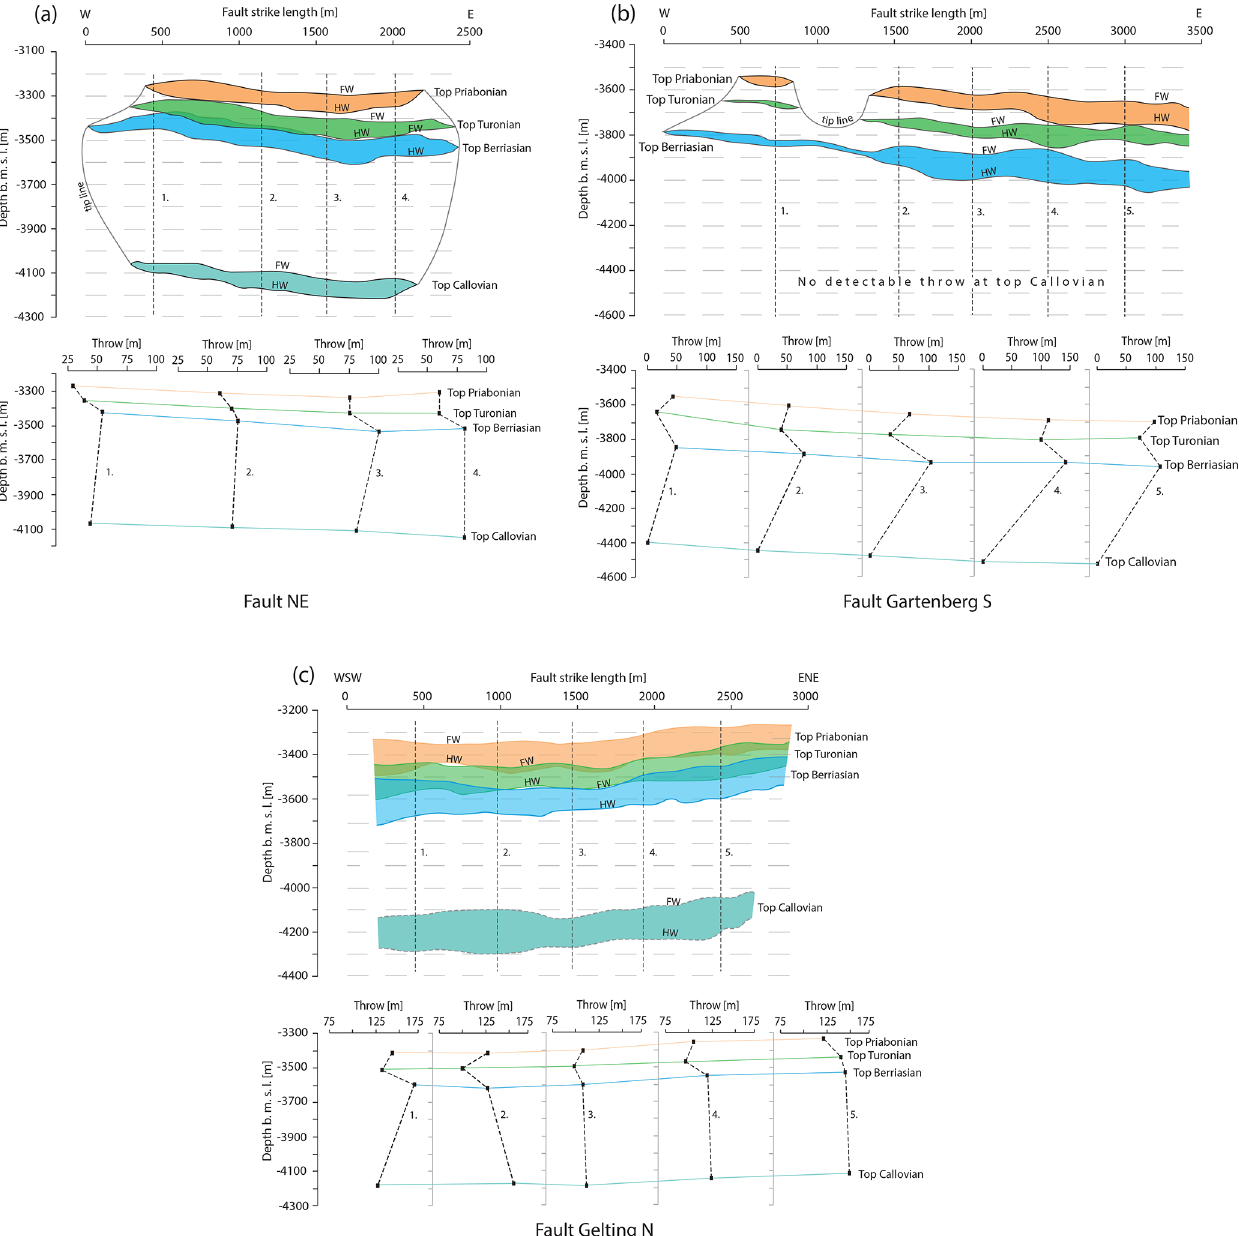
Figure 8. Allan maps and t – z plots for the (a) NE, (b) Gartenberg S, and (c) Gelting N faults. Footwall and hanging-wall cut-offs are abbreviated as FW and HW, respectively. (a) NE Fault: the throw decreases from top Berriasian stratigraphically upwards and downwards. The cut-offs of the horizons form a near-elliptical shape. (b) Gartenberg S Fault: the cut-off polygons show upward bifurcation of the Gartenberg S Fault. Note throw reduction at top Turonian. (c) Gelting N Fault: the throw distribution shows no significant throw variations along the displaced